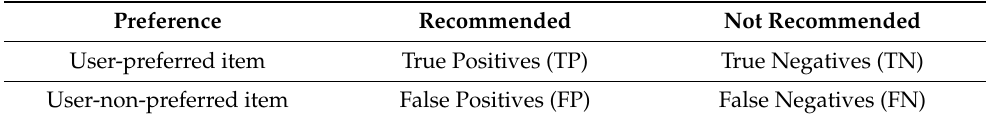
Table 2. Confusion Matrix of Recommendation